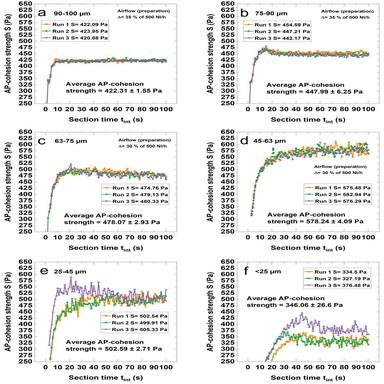
AP- cohesion strength (Anton Paar) of six powder fractions (a-f), measured in a powder cell.